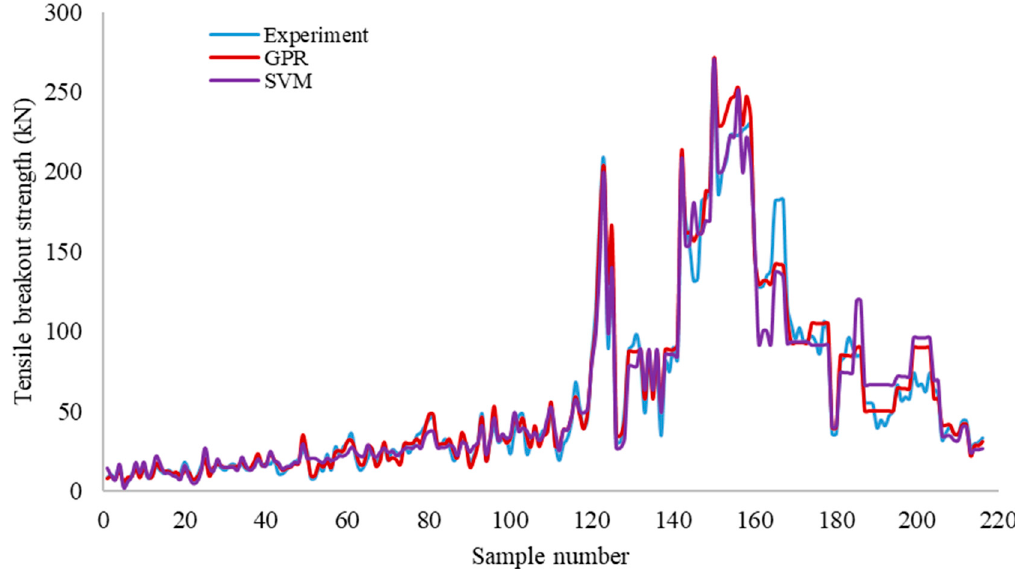
Figure 6. Comparison of predictions from the ML-based models to the experimental values using the testing dataset.